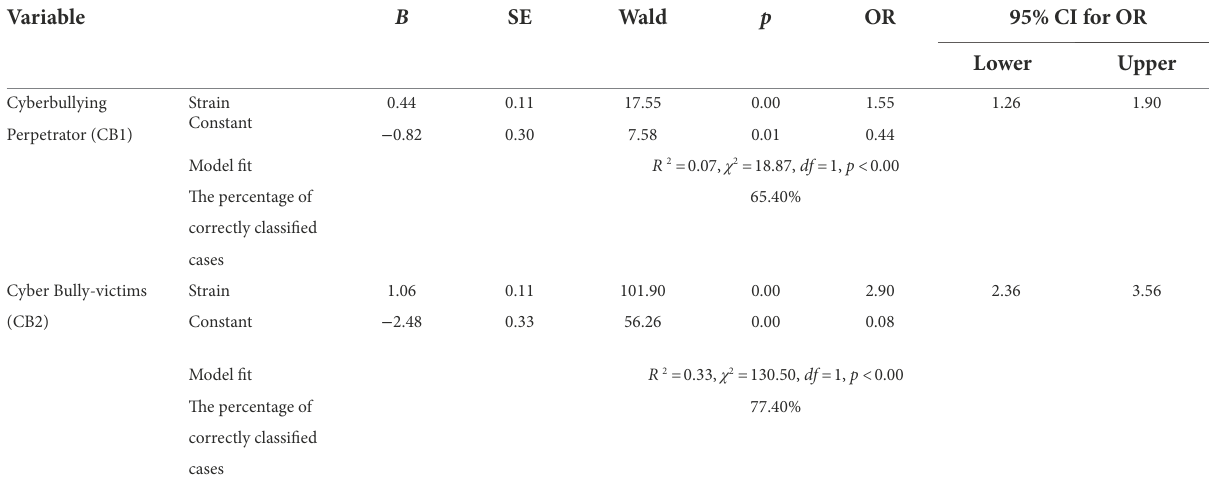
TABLE 3 Results of the binary logistic regression analysis of strain and cyberbullying.